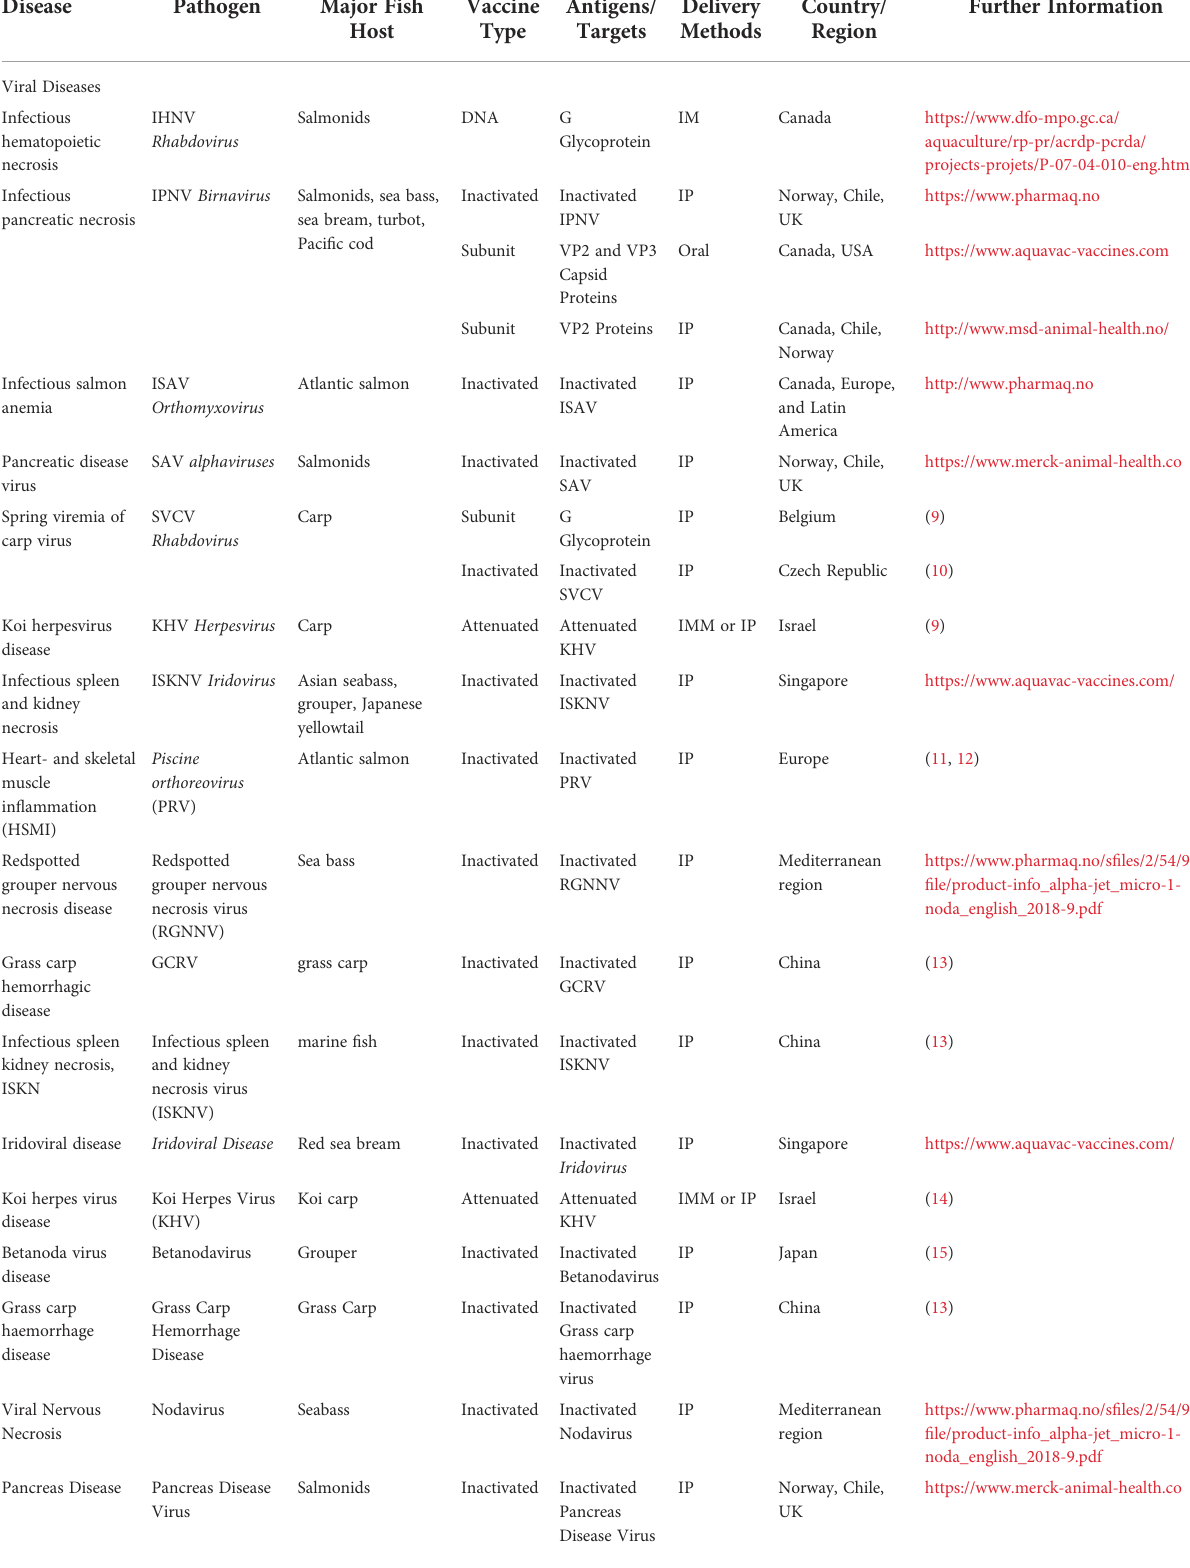
TABLE 1 Global commercial aquatic vaccines.